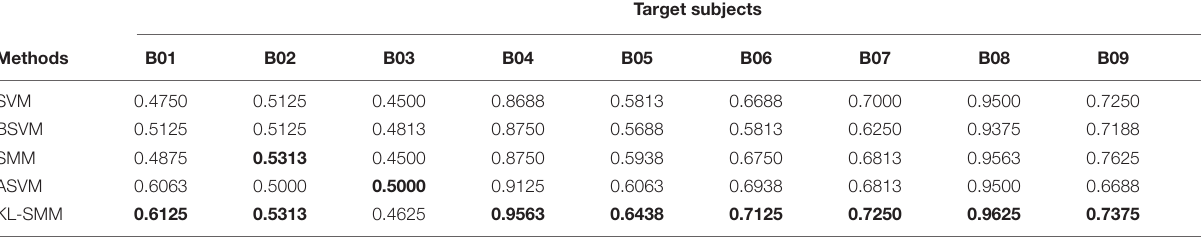
TABLE 5 | Comparison of AUC using 14 labeled target EEG data in Exp. 2 .